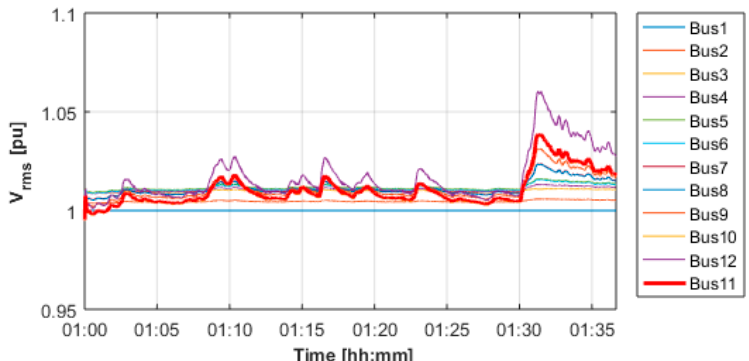
Figure 19. Voltage profiles along the MV distribution feeder where P2H assets are connected on bus 11 (red).